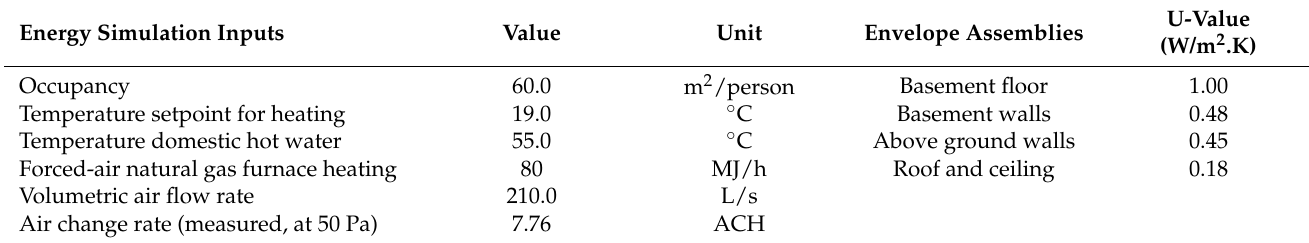
Table 5. Energy simulation inputs and parameters for the single-detached house.